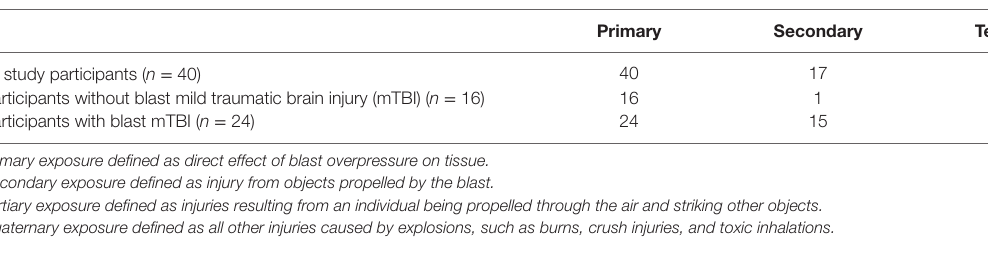
Primary Primary and only secondary